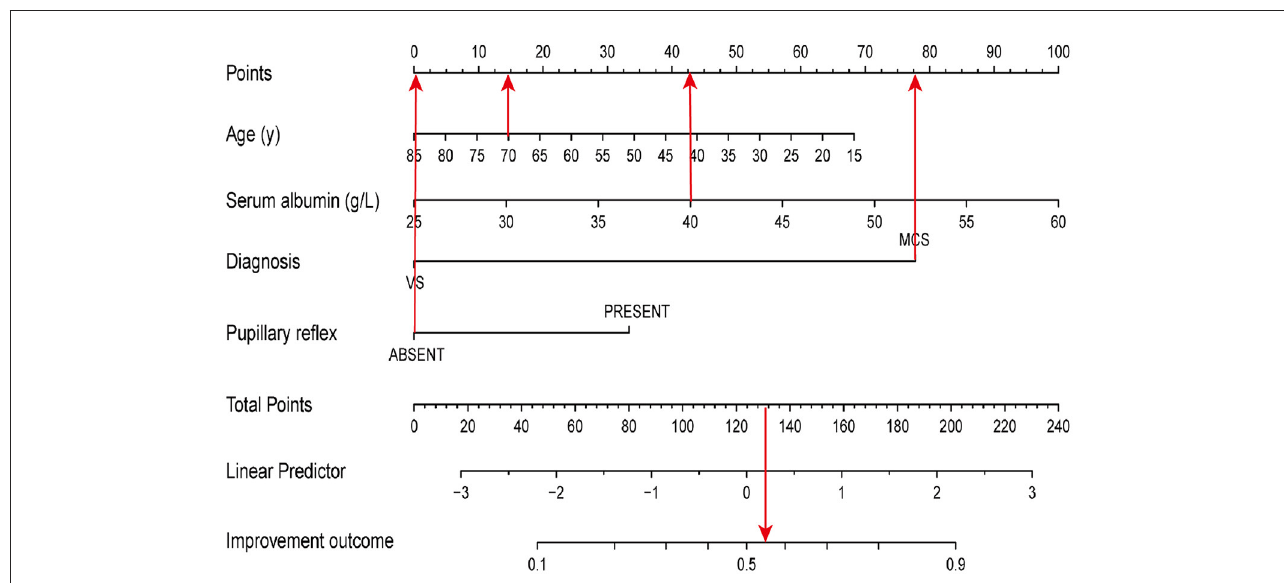
FIGURE2 A nomogram model to predict the clinical outcomes. The red arrows present the calculation of total points of a 70-year-old patient diagnosed with MCS, absence of bilateral light reflex, and a serum albumin concentration of 40 g/L upon entry within 2 months of